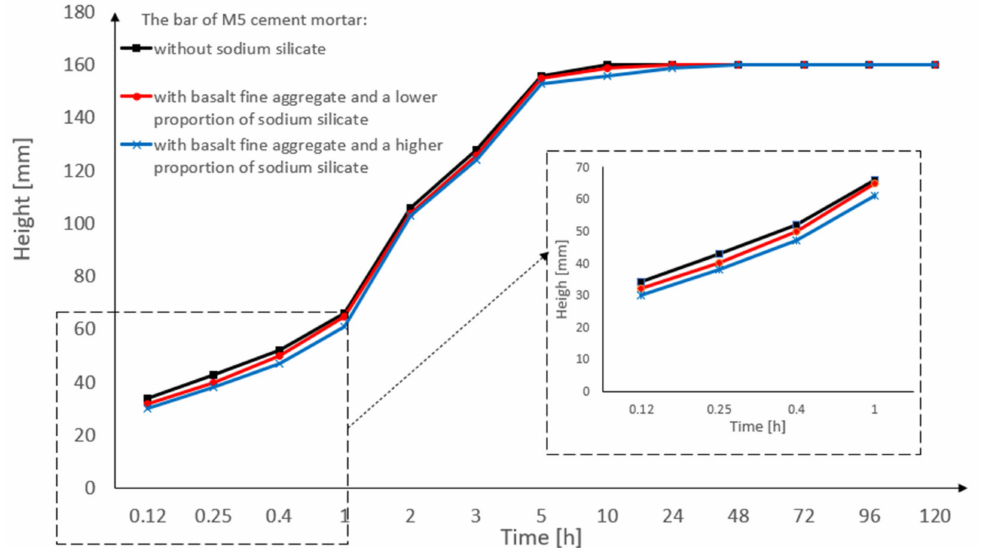
Figure 8. Capillary suction of the M5 cement mortar bar with the basalt fine aggregate: without sodium silicate, with a lower proportion of sodium silicate, and with a higher proportion of sodium